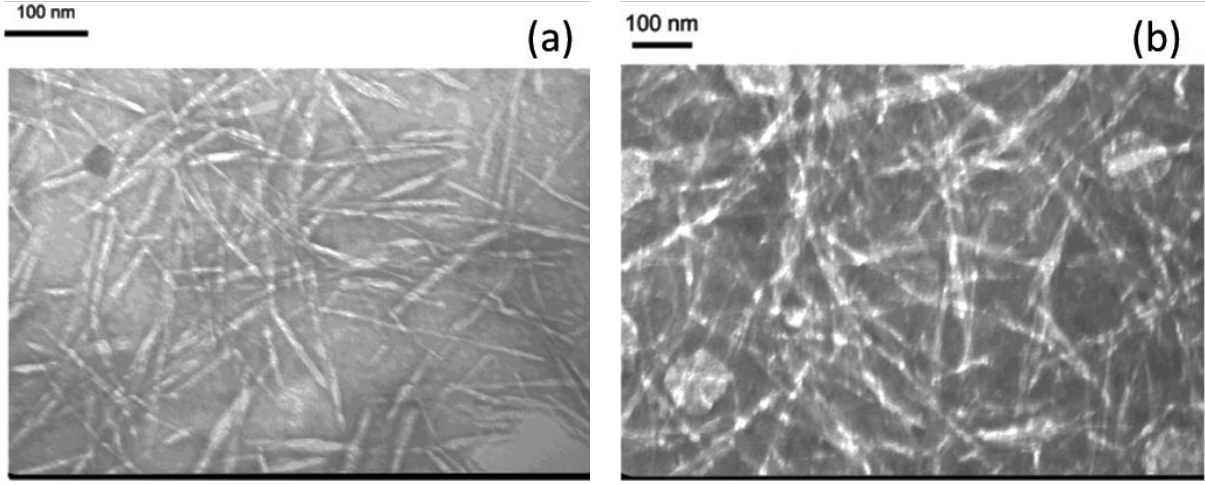
Figure 1. TEM observation of manufactured cellulose nanoparticles ( a ) (CNPs)-64 and ( b ) CNPs-48 material.